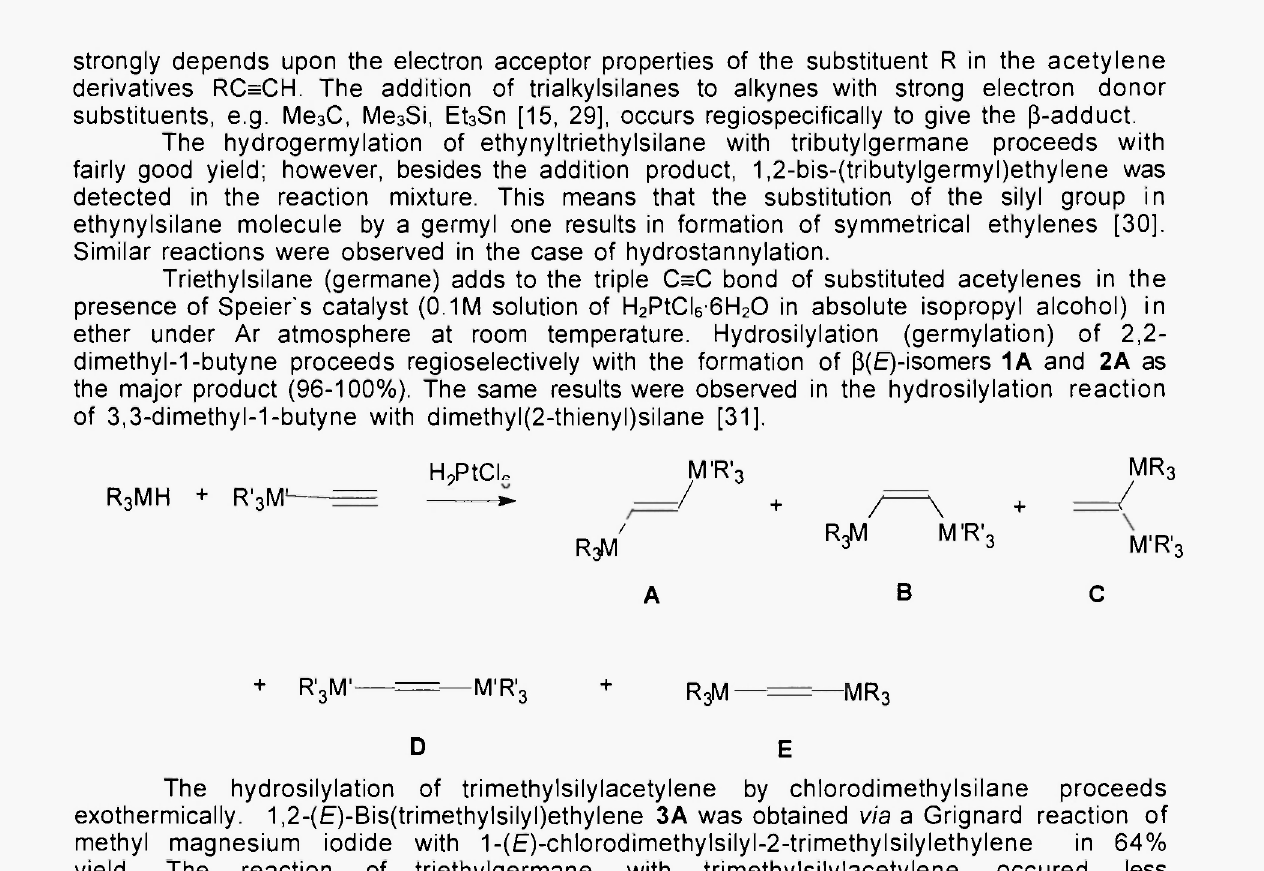
Table 1. Product ratio in the hydrosilylation (germylation) reaction (GC